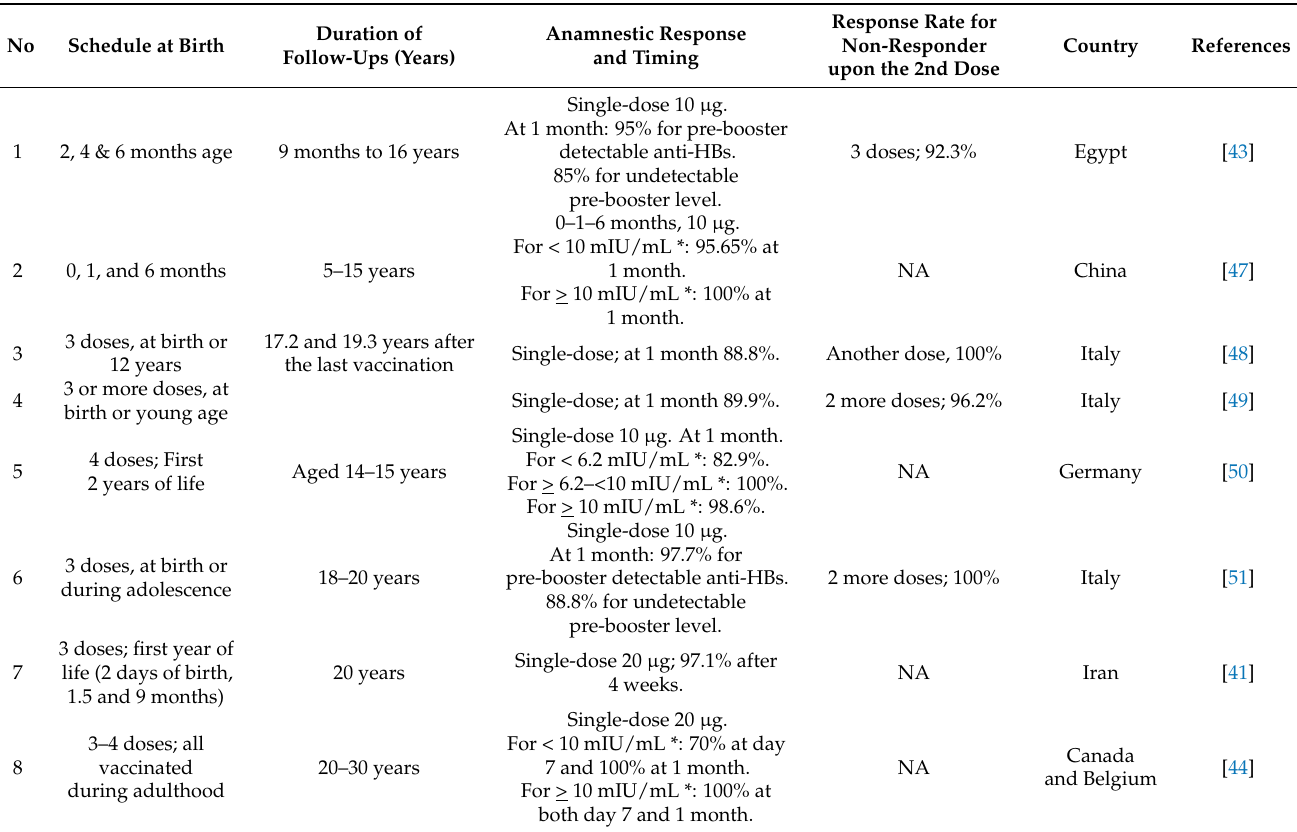
Table 1. Hepatitis B vaccine response in healthy